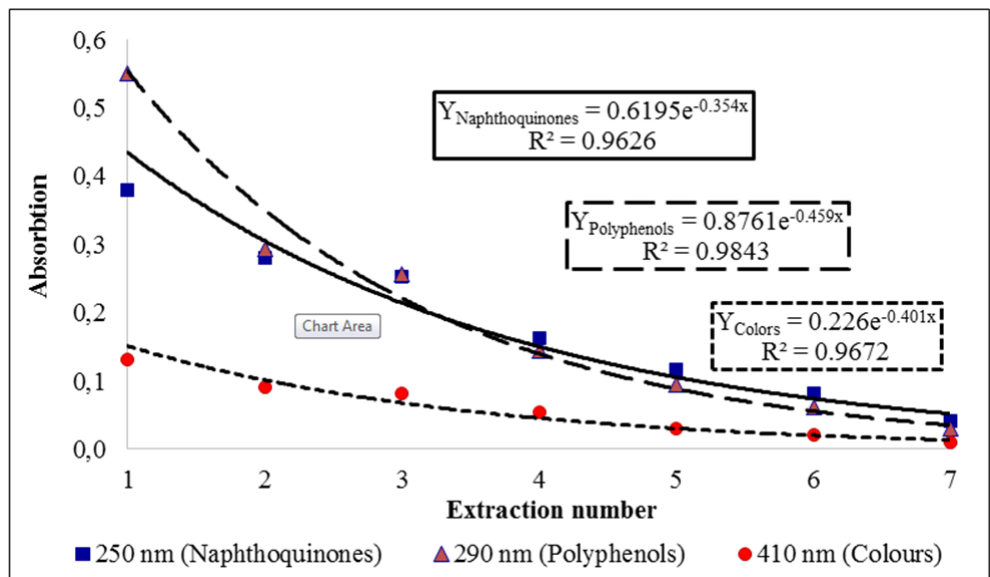
Figure 6. Changes in the UV-Vis absorptions in the consecutive extractions, exponential models.